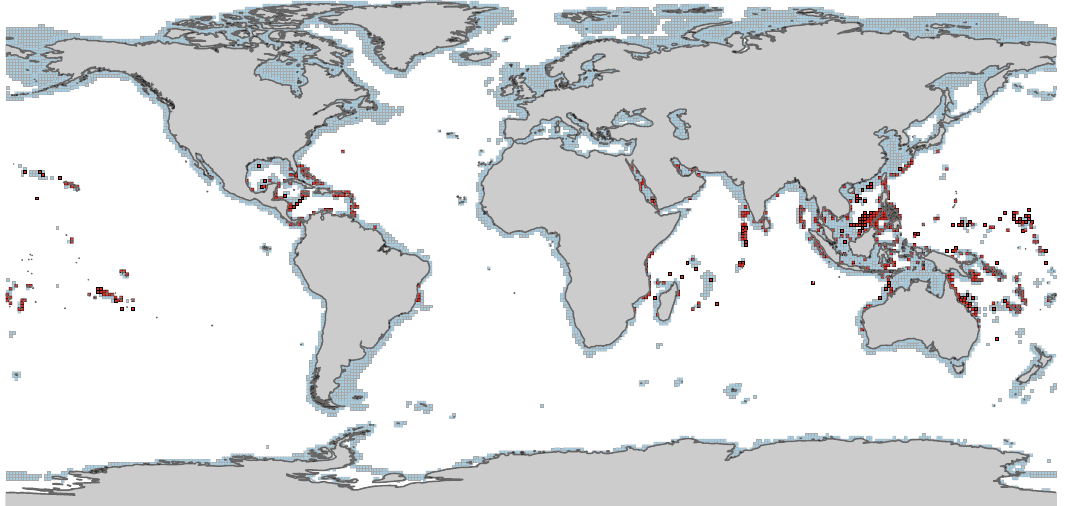
Fig. 1 Global map of present-day warm-water coral reefs from the ReefBase (http://www.reefbase.org/main.aspx). Distribution data are spatially subsampled at a horizontal resolution of 1° × 1° and fi ltered to include only ‘ true reefs ’ (see Methods). Presence cells ( n = 790) are depicted in red (cells containing at least one coral reef or community). Shallow-water mask cells ( n = 11,221) are depicted in blue, and denote areas of substrate depth <200 m. These cells were randomly sampled to generate background data and calibrate the habitat suitability model. Continents are depicted in light